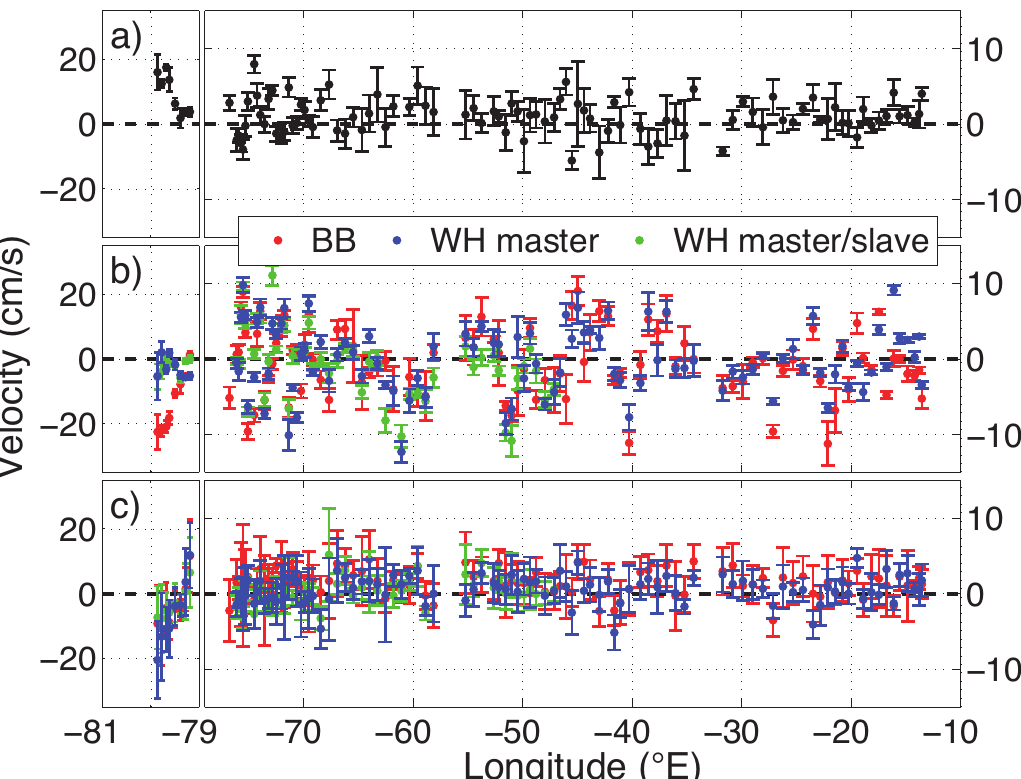
Fig . 3. – Statistical analysis carried out for the three different instruments deployed during the survey: a) mean and standard deviation of the differences between the BB and WH master bottom track measurements; b) mean and standard deviation of the differences between each LADCP full depth profile and their bottom track record in the depth range near the sea bottom; c) mean and standard deviation between each LADCP full depth profile and the SADCP profile in a depth range near the sea